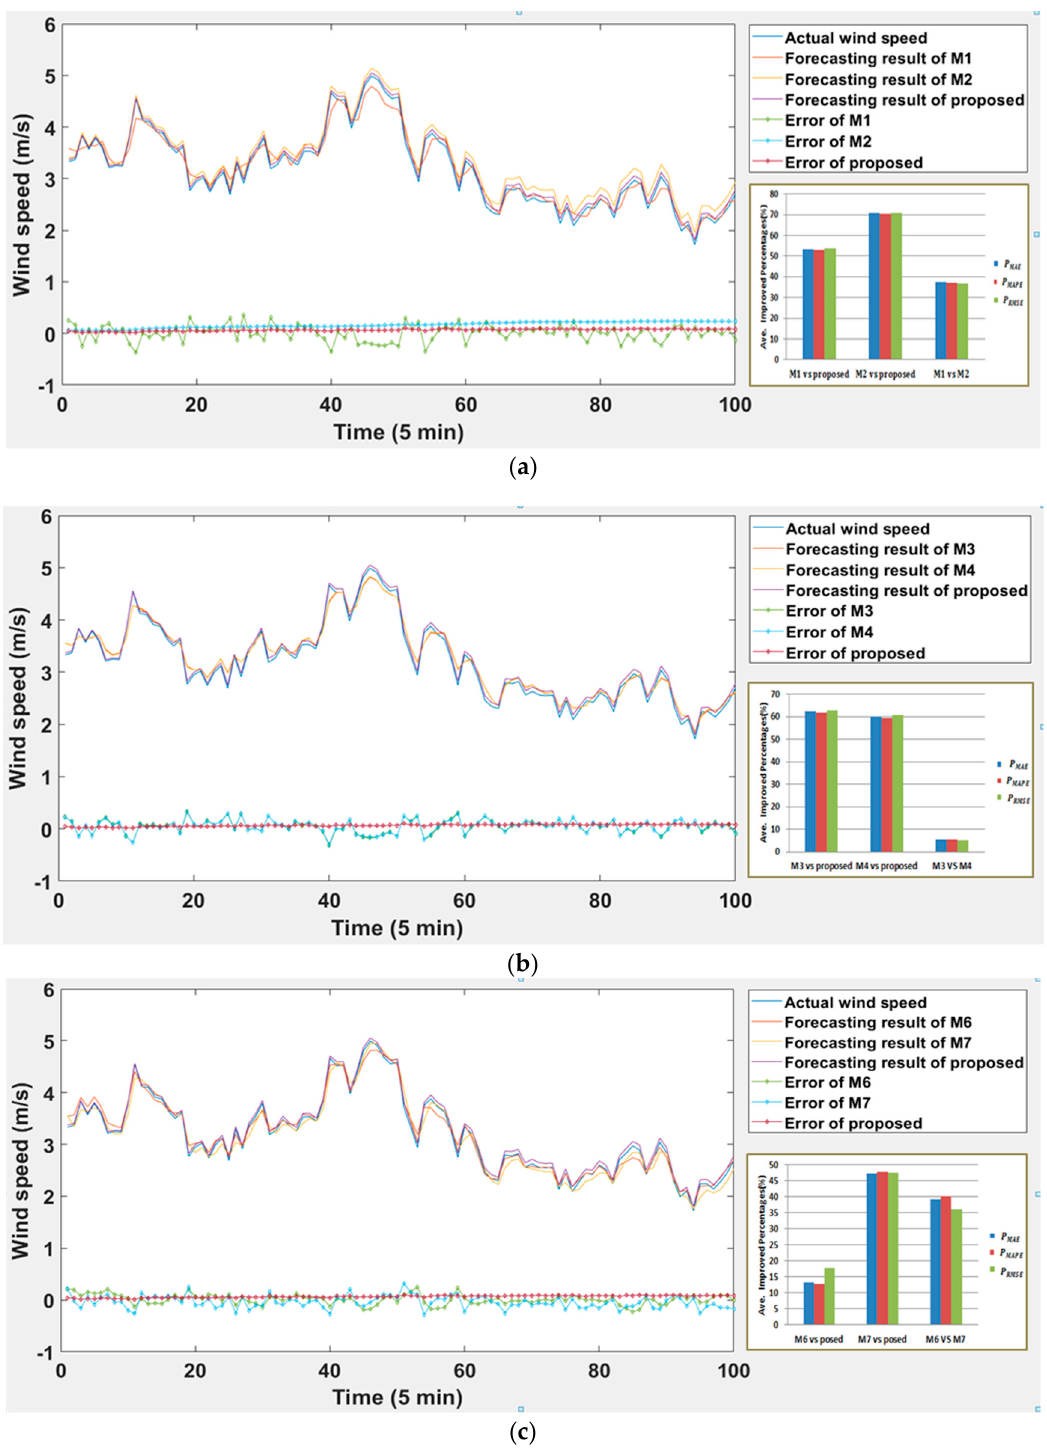
Figure 12. Supplemental case error analysis histogram: ( a ) MAE; ( b ) MAPE; ( c ) RMSE.